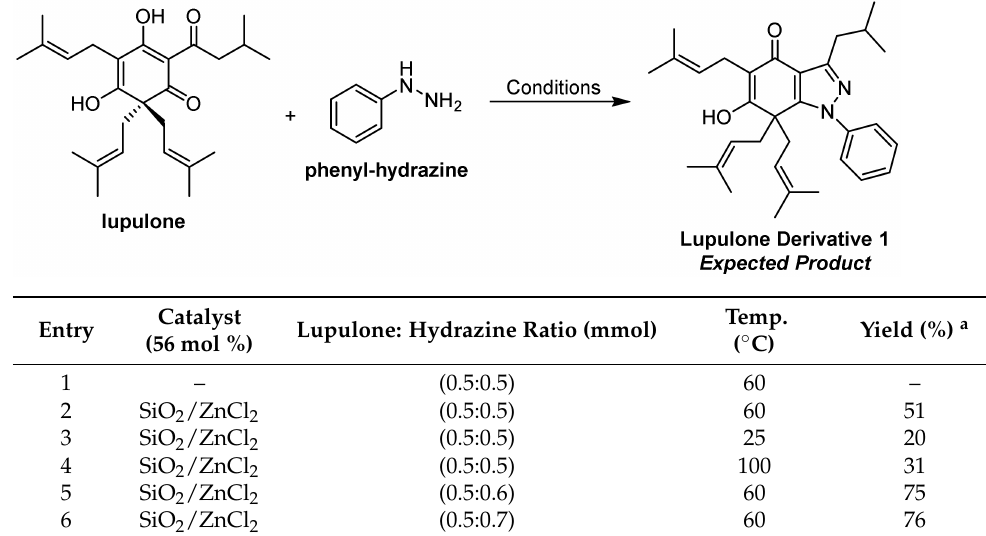
Table 1. Optimization of the reaction between lupulone and